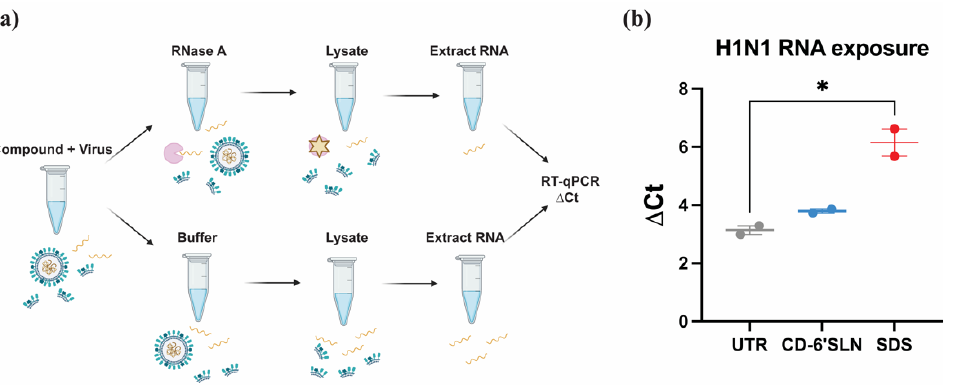
Figure 4. RNA exposure assay ( a ) Schematic drawing demonstrating the mechanism of the RNA exposure assay. The compound and virus were co-incubated for 3 h and then treated either with RNAse or buffer, followed by viral lysis. The RNA quantities in the lysate were quantified by RT-qPCR. ( b ) Cycle threshold difference ( ∆ Ct = Ct RNase − Ct control ) of H1N1 samples treated with 100 µ g/mL CD-6 (cid:48) SLN and 100 µ g/mL SDS. Results are expressed as average ± standard deviation based on two independent experiments. The asterisk represents the p -value (*, <0.05) calculated by a two-tailed unpaired t-test.